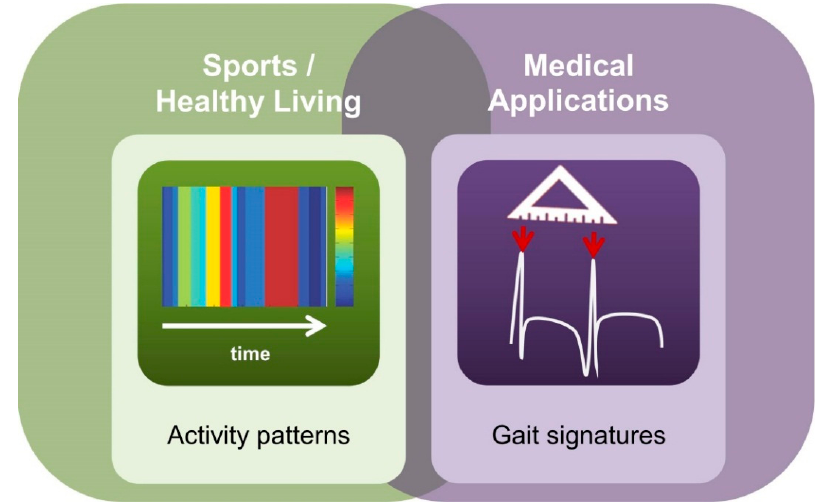
Figure 4. ( Left ): A schematic illustration of activity pattern variation over time, which is often referred to as an activity barcode [26]; barcode printed with permission of the authors. ( Right ):